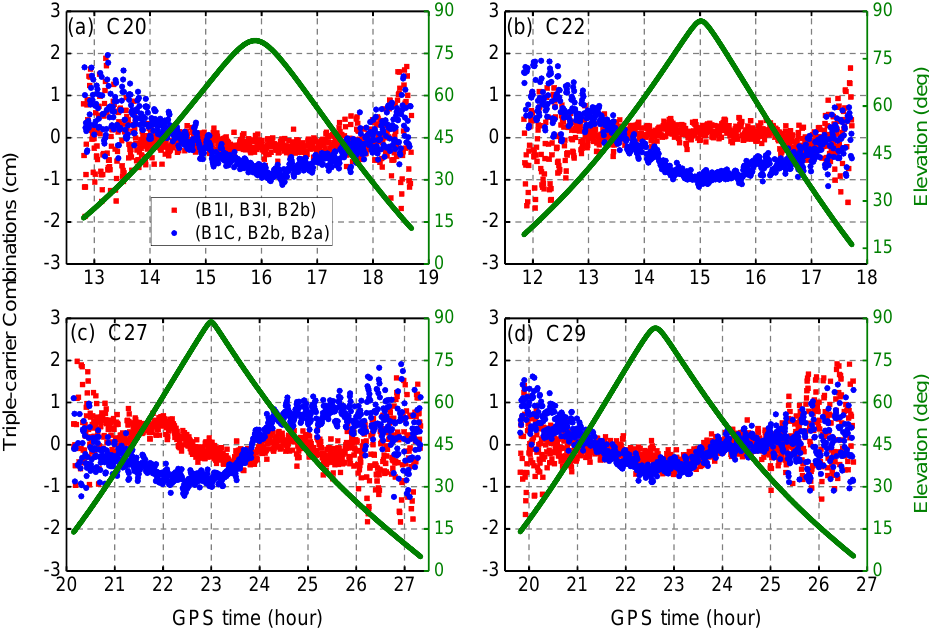
Figure 9. Variations of triple-frequency carrier phase combinations of (B1I, B3I, B2b) and (B1C, B2b, B2a) for C20, C22, C27, and C29 satellites during a pass at station HMNS.